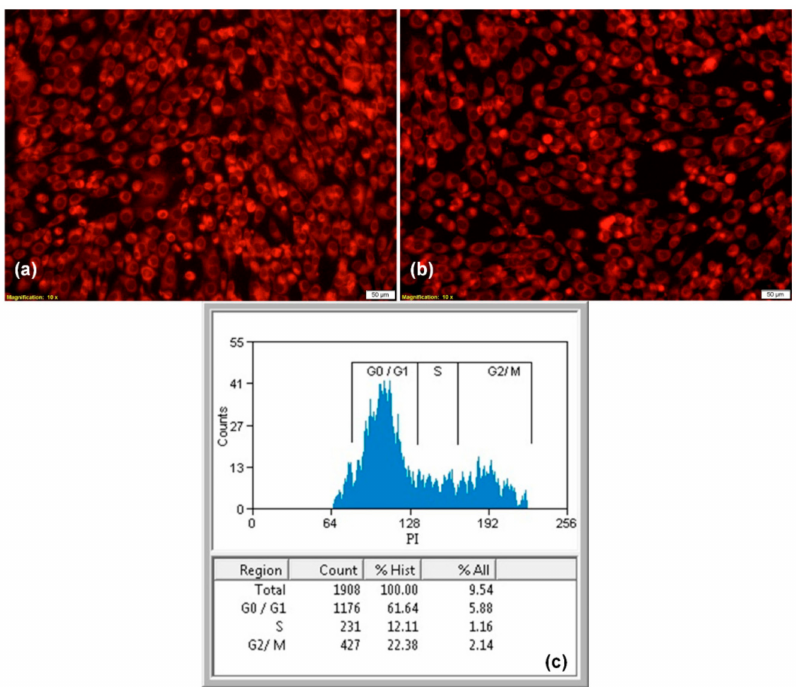
Figure 7. Fluorescence micrographs of human endothelial cells cultured after 5 days on control ( a ) and composite PLA / AgNPs coatings ( b ), 50 × magnification; the corresponding cell cycle after 48 h of incubation ( c ) (n = 3, * p < 0.05).